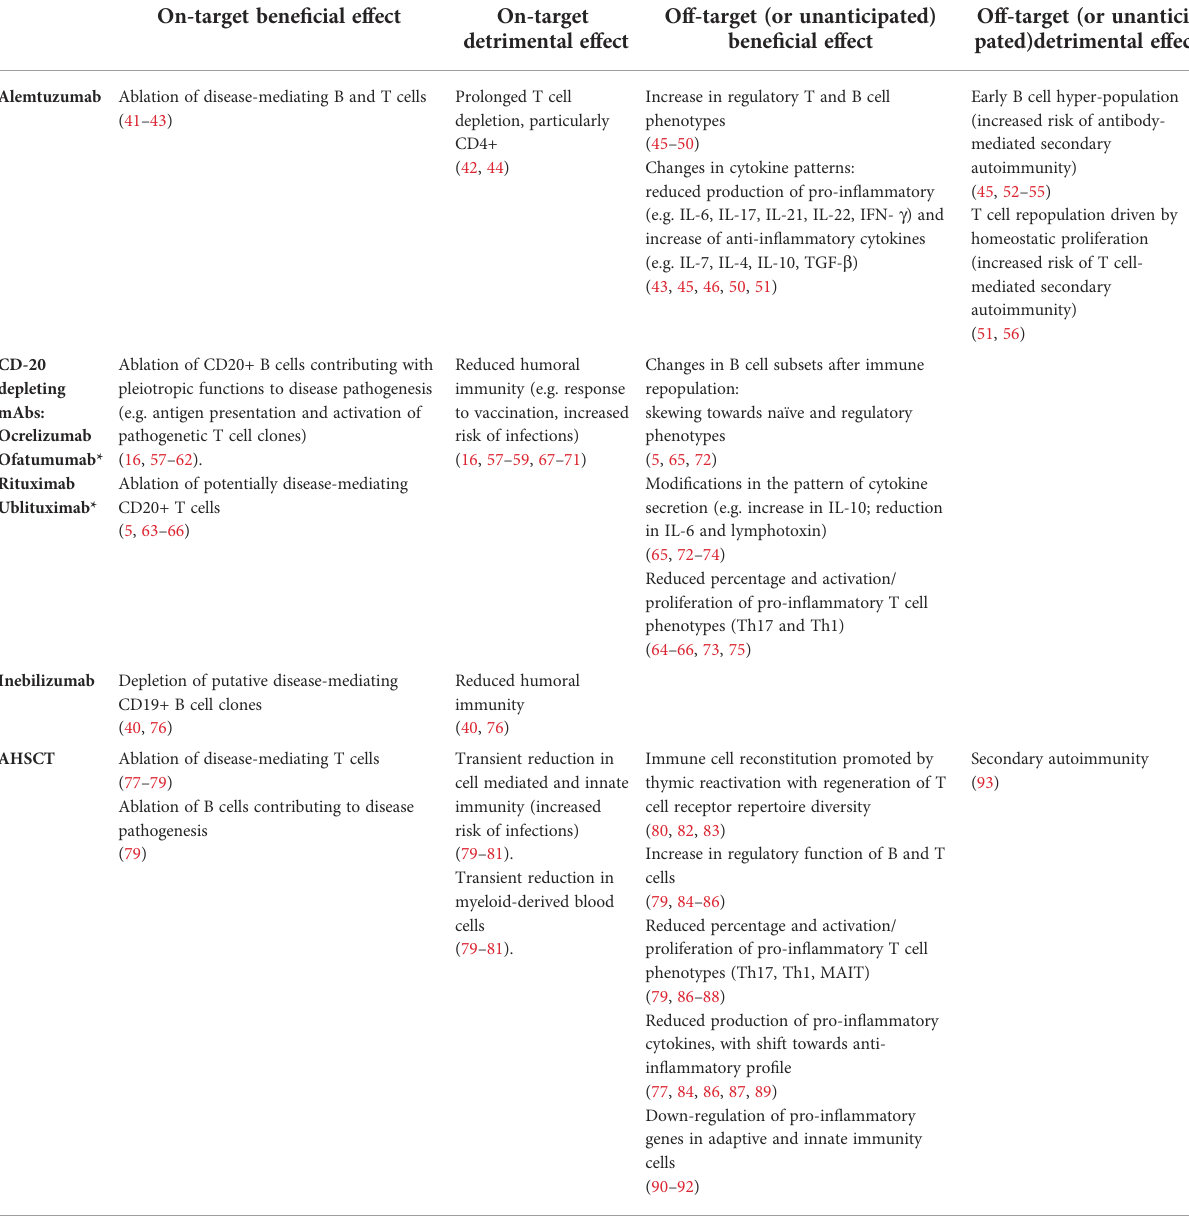
TABLE 2 Summary of on- and off-target effects on the immune system of therapeutic cell-depleting mAbs and relationship with bene fi ts and risks of adverse